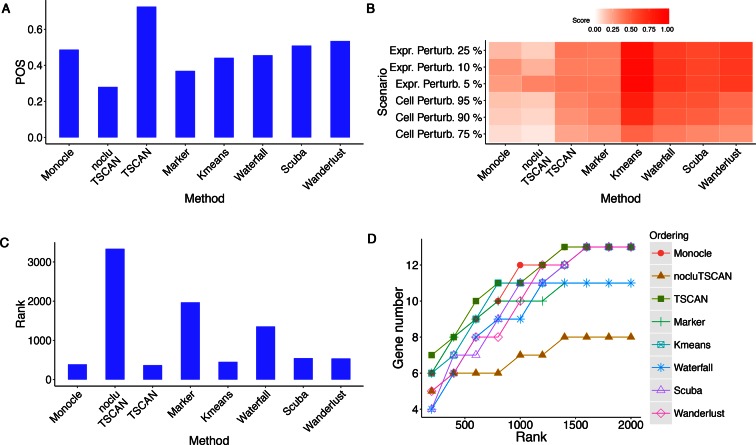
Evaluation results for different methods in HSMM data set where pseudo-time was
constructed based on 518 a priori chosen genes.
(A) POS score. (B) Robustness measured by the average
similarity score from 100 independent perturbations. The heat map shows robustness of
each method in each perturbation scheme. Cell Perturb: cell-level perturbation. Expr
Perturb: expression-level perturbation. (C) Mean rank of gold standard
genes. (D) Number of detected gold standard genes among top differential
genes.